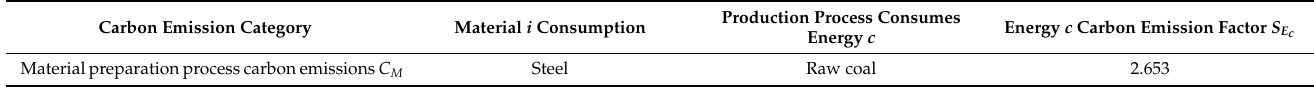
Table 4. Material preparation process carbon emission factor.